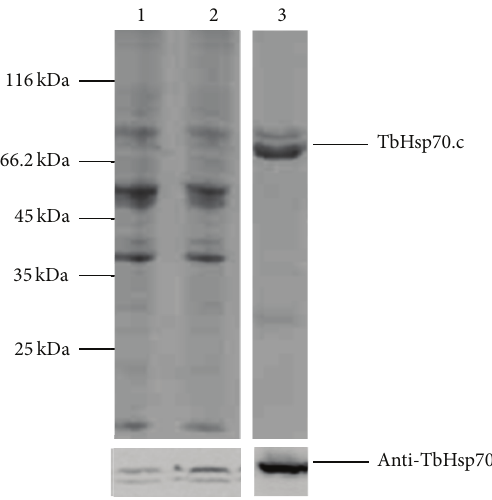
Figure 6: TbHsp70.c expression is enhanced under heat stress. Detection of TbHsp70.c expression levels in a whole cell lysate prepared from Lister 927 T. b. brucei v221 cells in the absence (37 ∘ C) and presence (42 ∘ C) of heat stress by 10% SDS-PAGE ( 5 × 10 6 cells/lane); western analysis revealed that TbHsp70.c is heat inducible. Upper panel: Lanes 1 - cells incubated for 1 hour at 37 ∘ C; 2 – cells incubated for 1 hour at 42 ∘ C; 3 – purified recombinant TbHsp70.c in E. coli BB1994 [pQE80-TbHsp70.c]. Lower panel: Lanes 1 – 3 - detection of target protein by western analysis using anti-TbHsp70.c antibody, showing increased expression levels of TbHsp70.c under heat stress. The experiment was performed in triplicate using three different whole cell lysates and the figure represents the findings of a typical